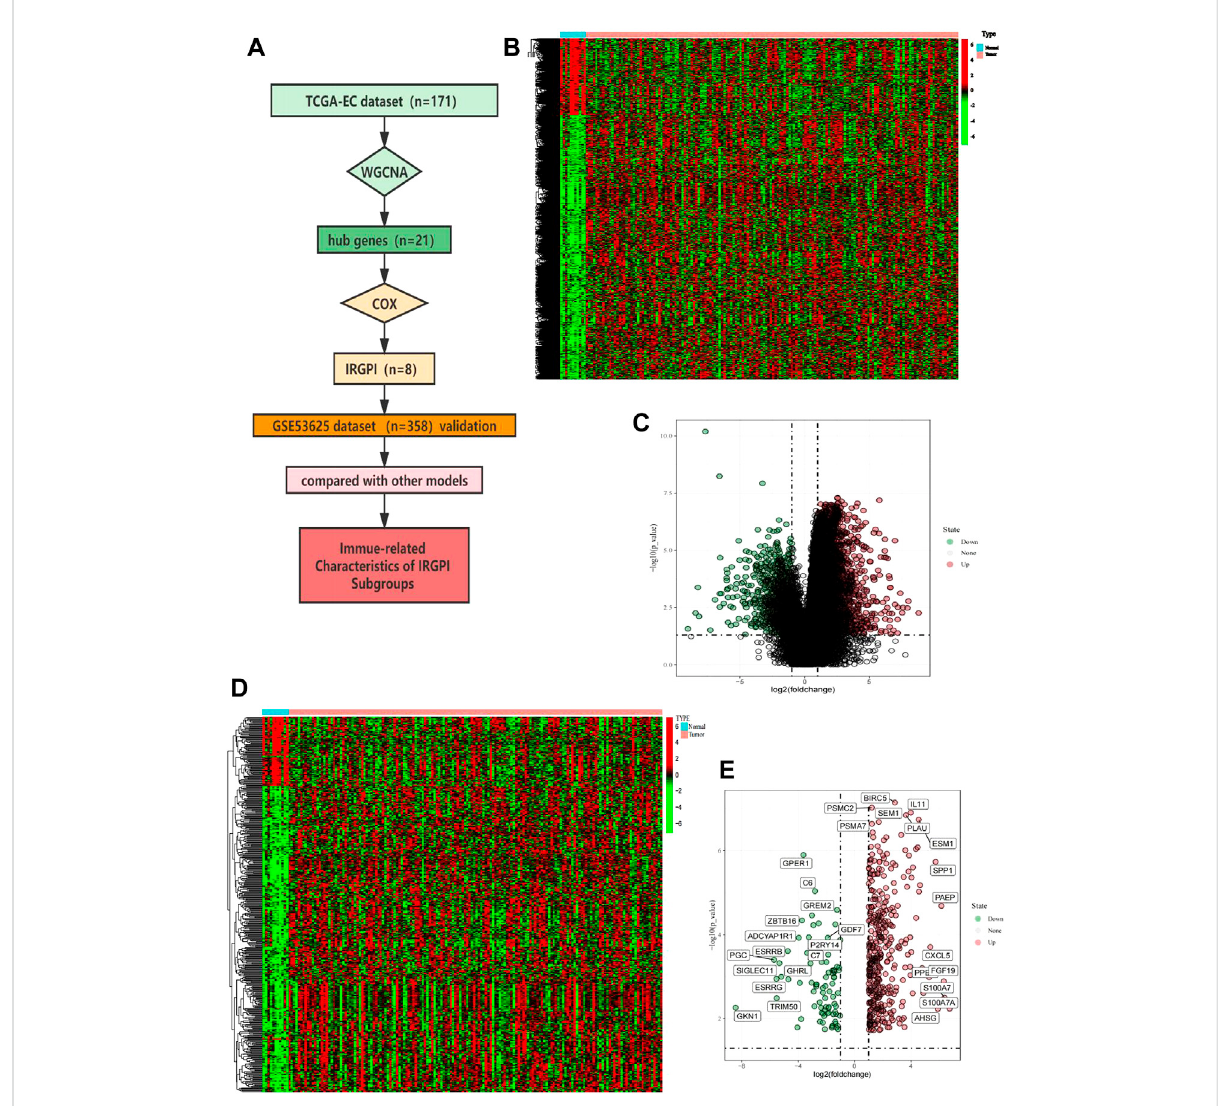
FIGURE 1 Overallanalysiswork fl owandselectedIRGs. (A) Schematic fl owchartofthework fl owperformedtobuildandvalidatetheECprognosticmodel. (B) Heatmap of DEGs; red plots: cancer sample; green plots: normal sample; black plots: normally expressed mRNAs. (C) Volcano plot of DEGs; red plots:upregulation.Greenplots:downregulation. (D) Heatmapofimmune-relatedIRGs;redplots:cancersample;greenplots:normalsample;black plots: normally expressed mRNAs. (E) Volcano plot of IRGs; red plots: upregulation. Green plots: